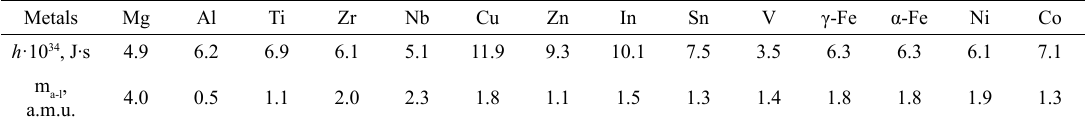
, calculated for studied -l